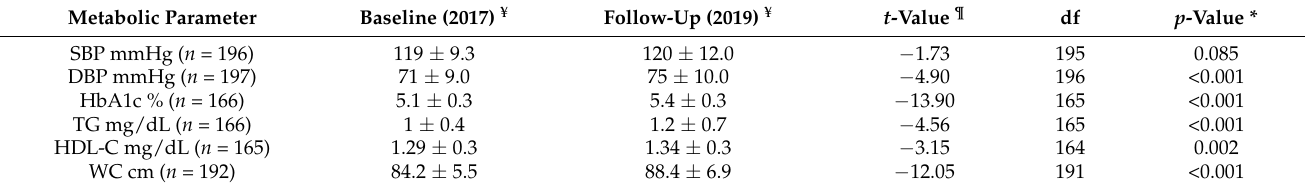
Table 5. Comparison of metabolic parameters at baseline and follow-up.